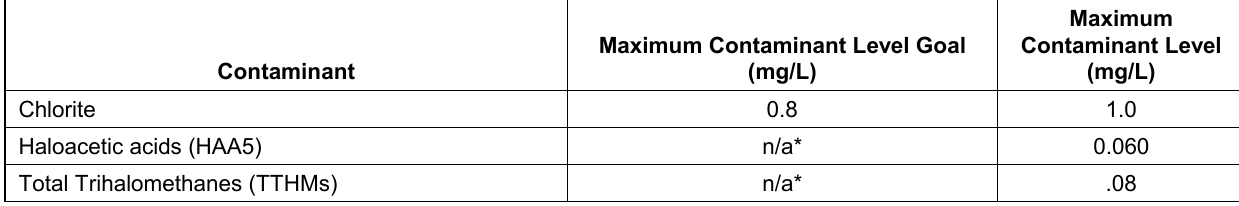
Table 3. EPA national primary drinking water standards for disinfection